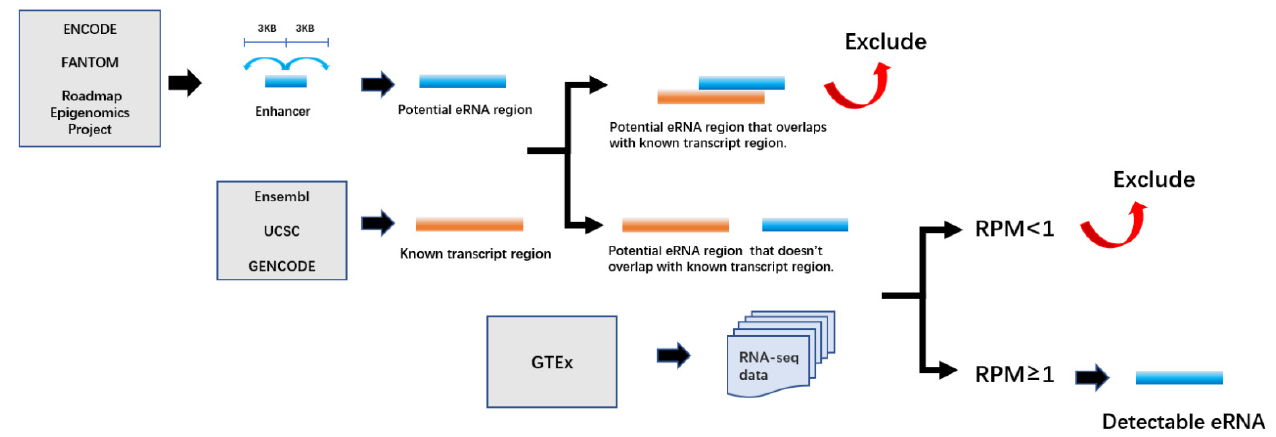
Figure 3. Pipeline for eRNA detection.